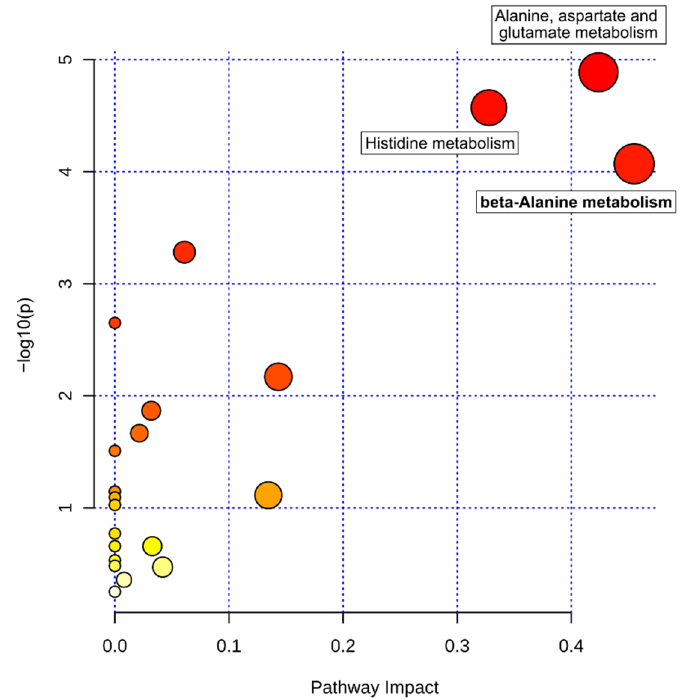
Figure 2. Metabolic pathway analysis of tumor metabolites. The metabolome view shows matched pathways arranged by p -values from pathway enrichment analysis (Y-axis) and pathway impact values from pathway topology analysis (X-axis). Node color and radius are based on the p -value and pathway impact value, respectively.